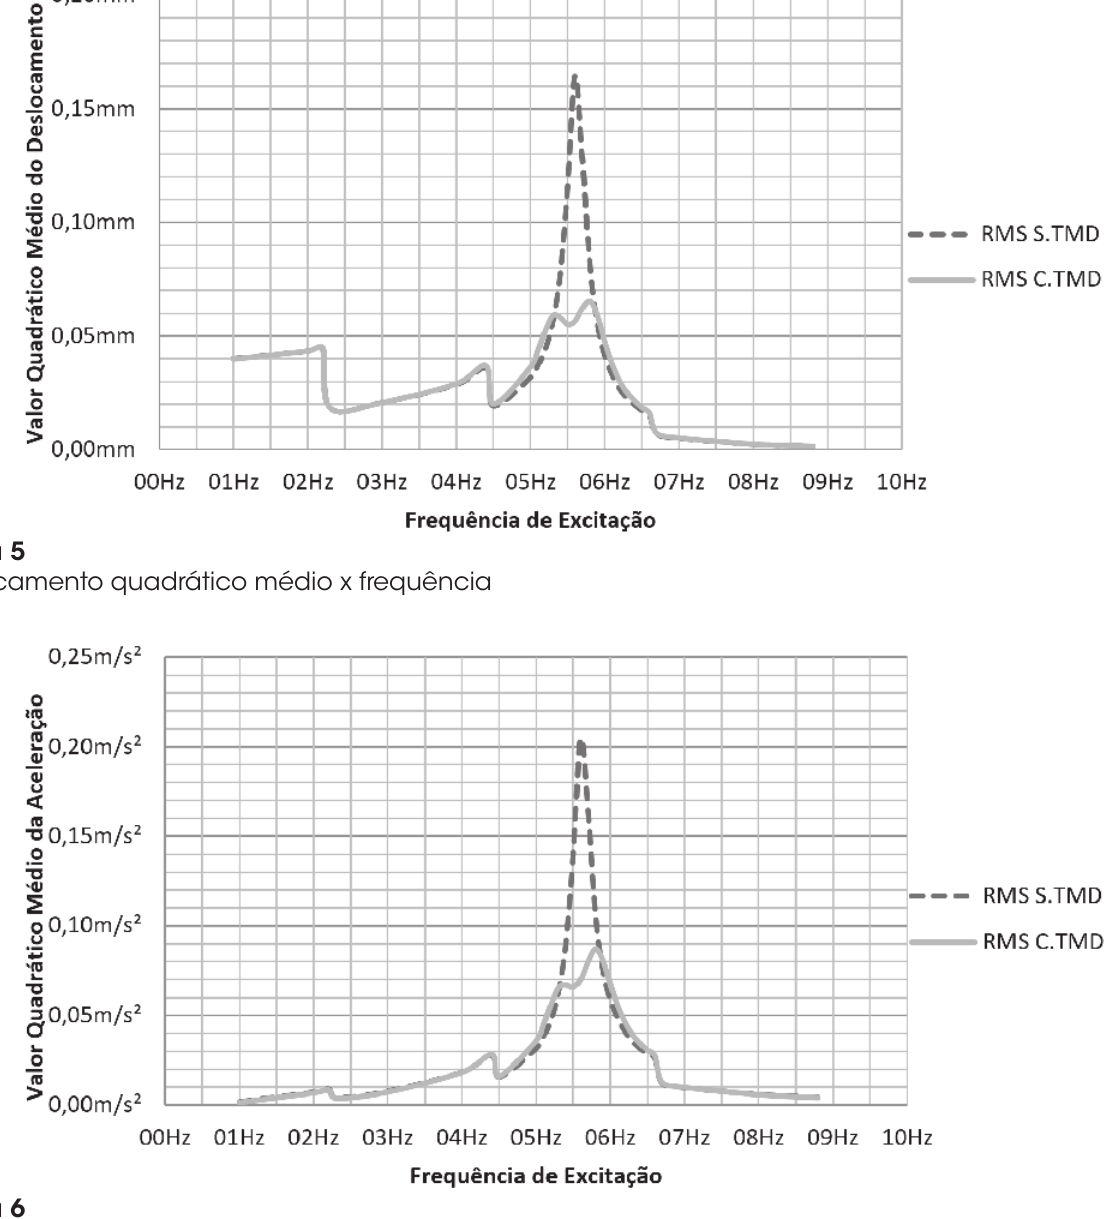
Figura 6 Aceleração quadrática média x